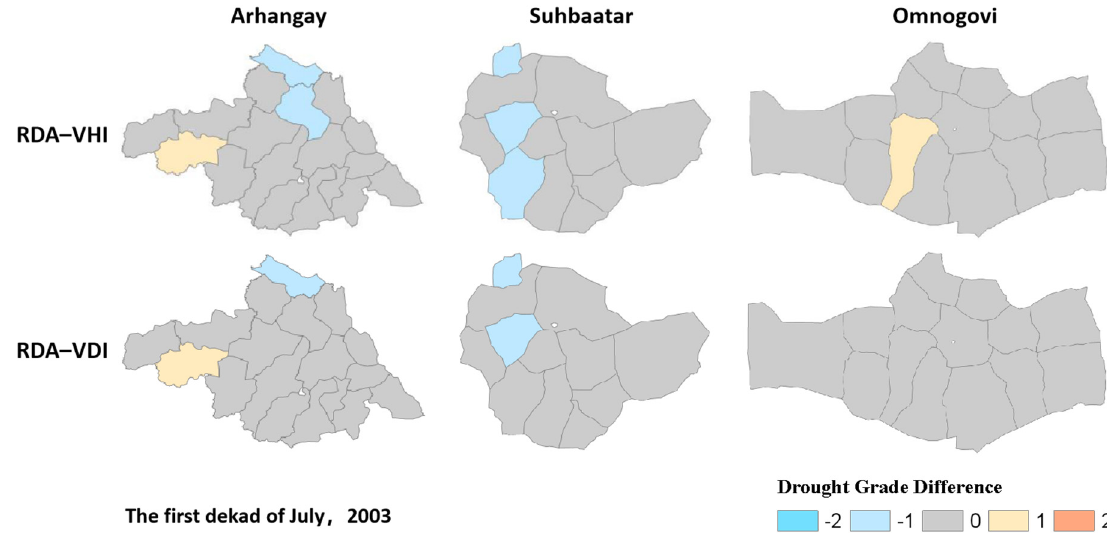
Remote Sens. 2021 , 13 , x FOR PEER REVIEW Figure 8. Drought grade differences for the averaged VHI, VDI, and RDA(RDA–VHI, RDA–VDI) at the county level in the first dekad of July, 2003, for three typical provinces.